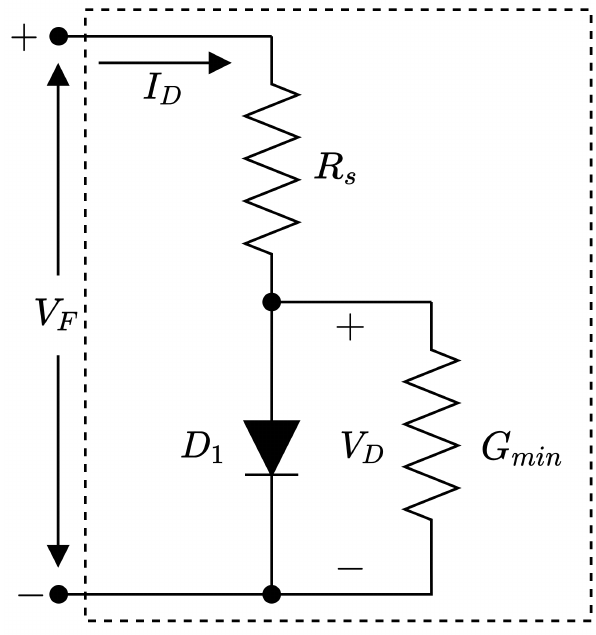
Figure 7. The SPICE large-signal diode model